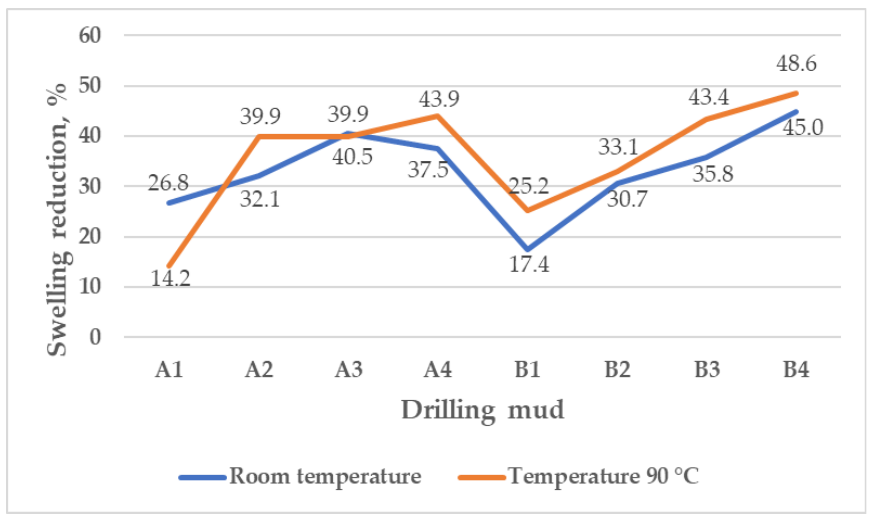
Figure 11. Pellet swelling reduction in different mud samples with added MPP in regard to base mud (BM) within 24 h.